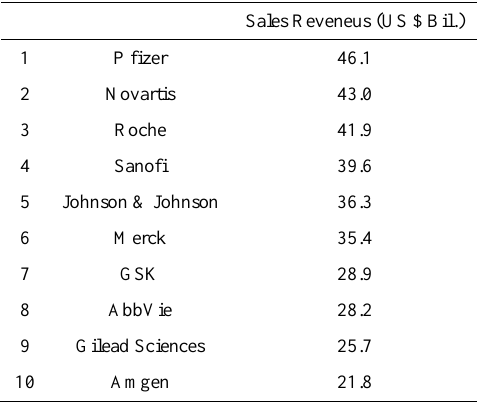
Table 3. Top 10 pharmaceutical companies in the world.